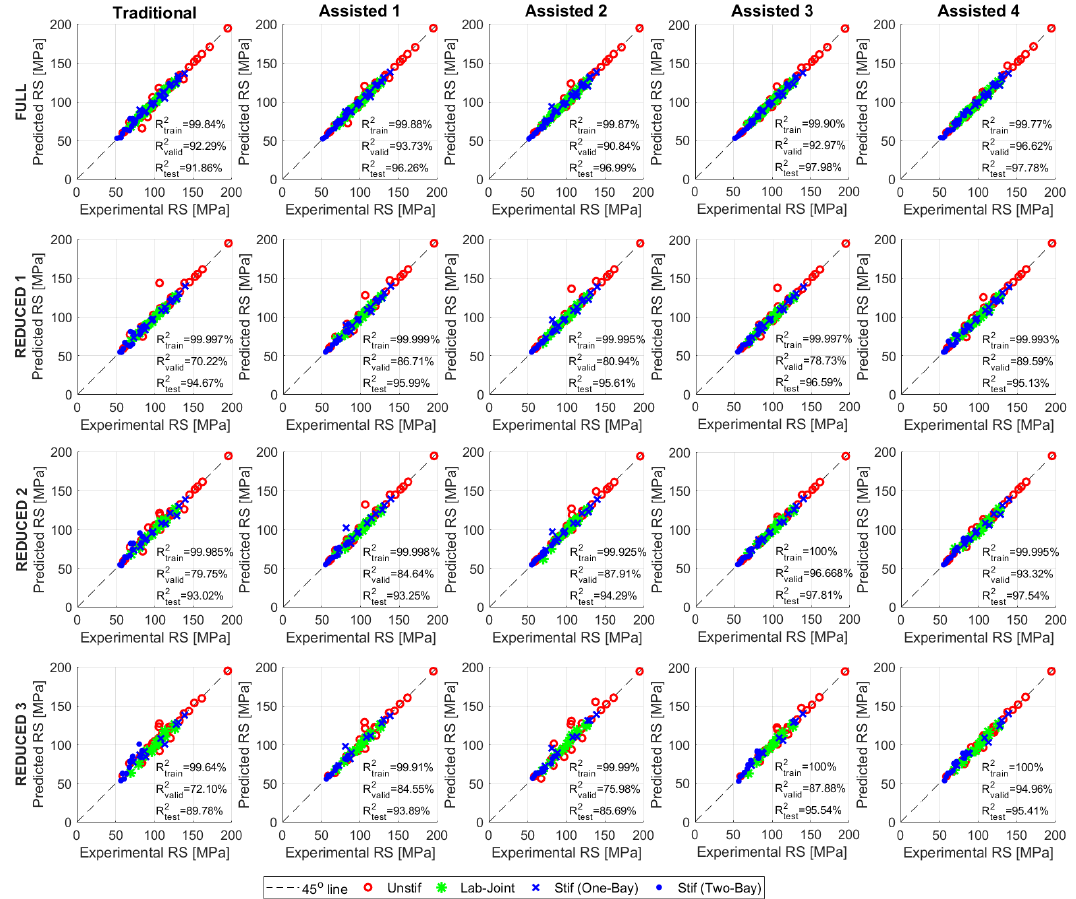
Figure 7. Effect of the assisted modeling approach and training dataset size on the correlation of ANN predictions with experimental residual strength values (for all data points used for training, validation, and testing). The effect of the assisted approach is observed when moving from left to right, while the effect of training dataset size reduction is observed when moving from top to bottom. The shown ANN predictions are for one of the 80 training/validation/testing datasets random combinations.